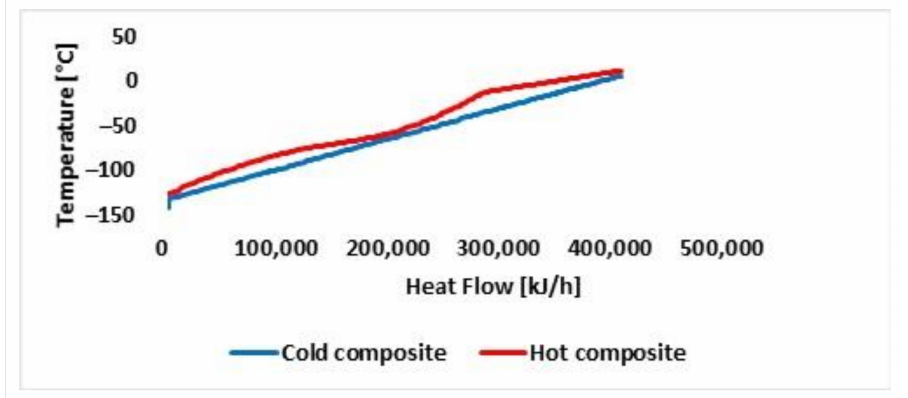
Figure 16. Heat transfer composite curves for AC-3